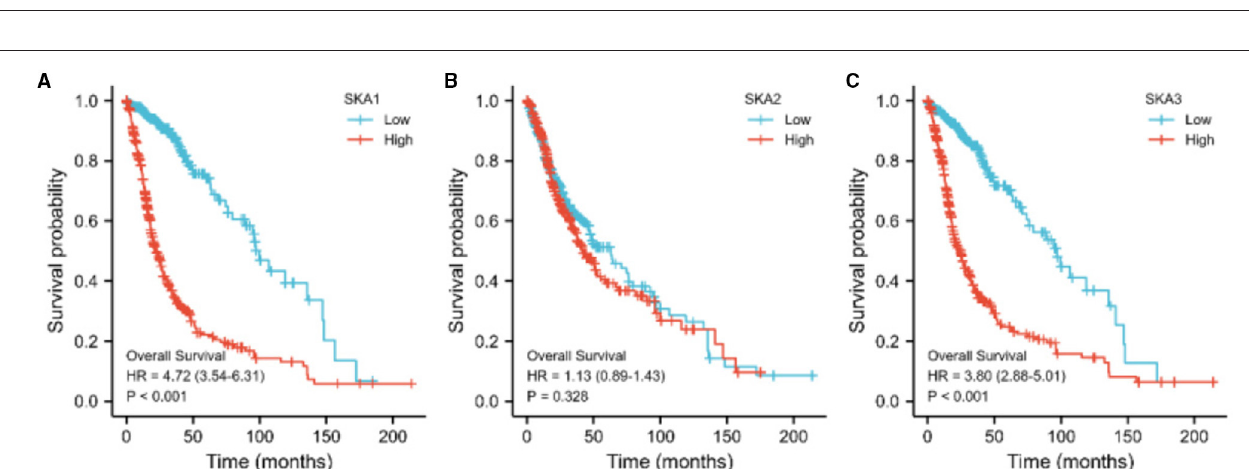
FIGURE 5 | The relationship between the expression of (A) SKA1, (B) SKA2, and (C) SKA3 with OS of patients with gliomas in the GEPIA database.